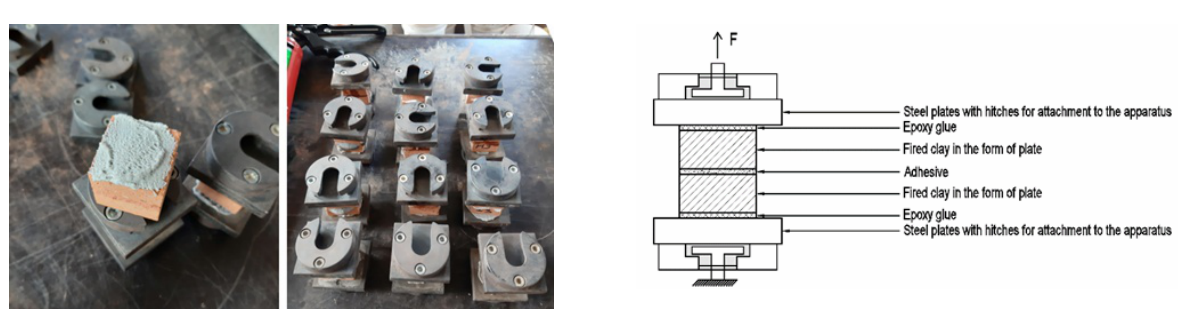
Figure 6. The scheme of adhesion test.